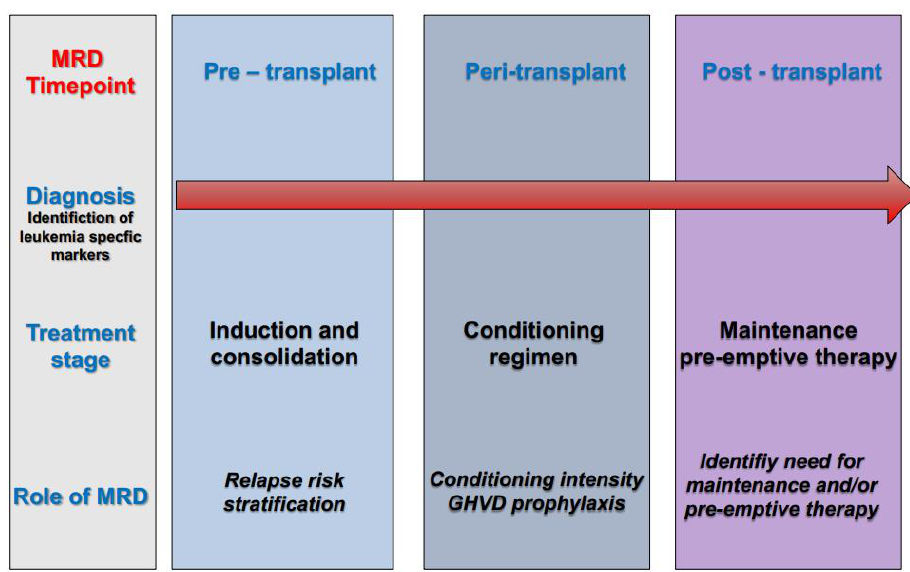
Figure 2. Role of measurable residual disease (MRD) at different timepoints of the treatment pathway in acute myeloid leukemia (AML).